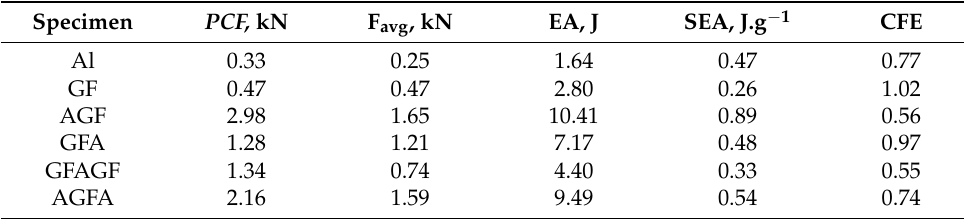
Table A4. Comparison of the average lateral crashworthiness